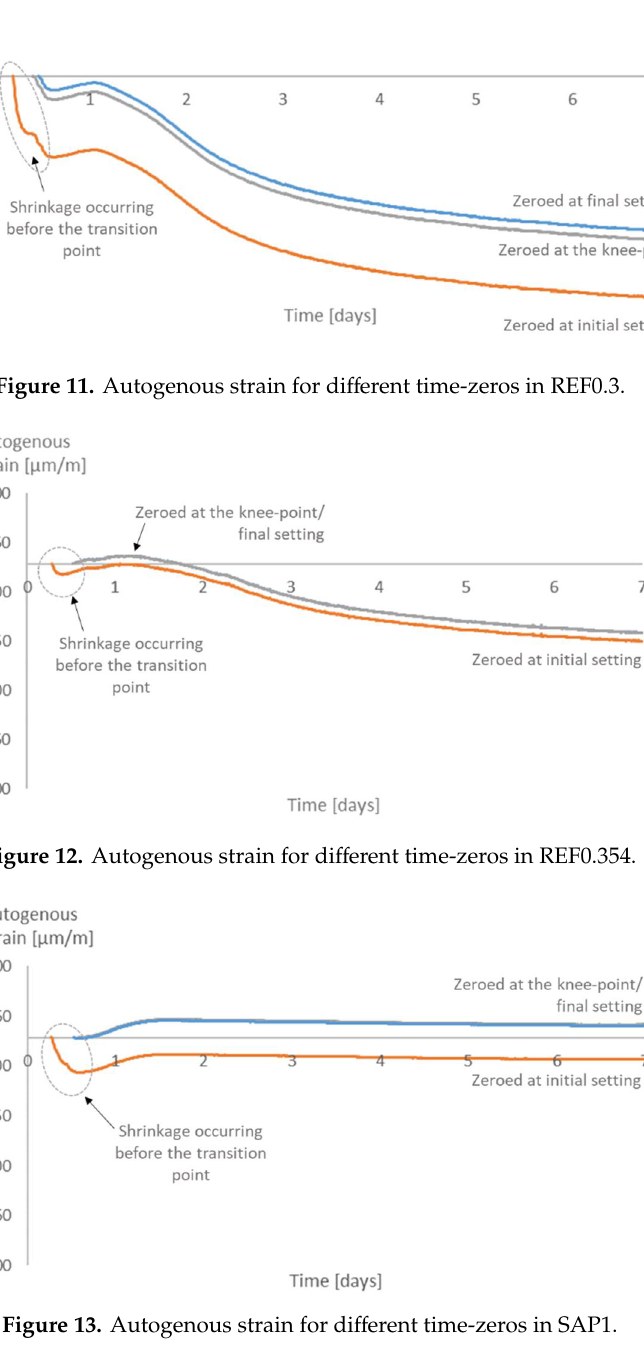
Figure 11. Autogenous strain for different time-zeros in REF0.3.